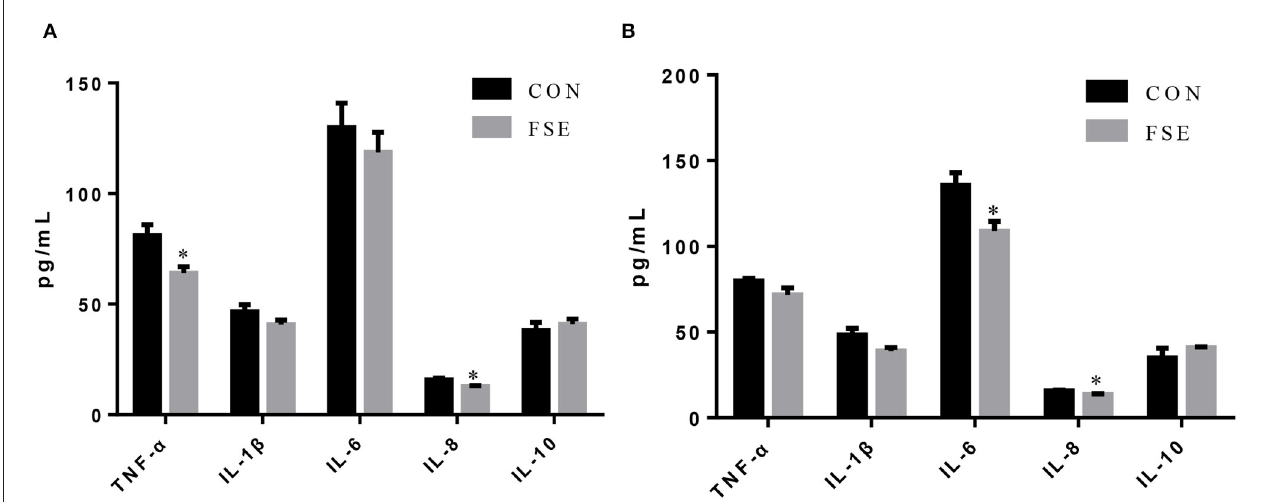
FIGURE 4 | Effects of Forsythia suspensa extract on inflammatory cytokines in serum of lactating sows. CON, control treatment; FSE, Forsythia suspensa extract treatment. (A) Inflammatory cytokines in serum of sows at farrowing; (B) Inflammatory cytokines in serum of sows at weaning. All values are expressed as means ± SEM ( n = 6). * P <